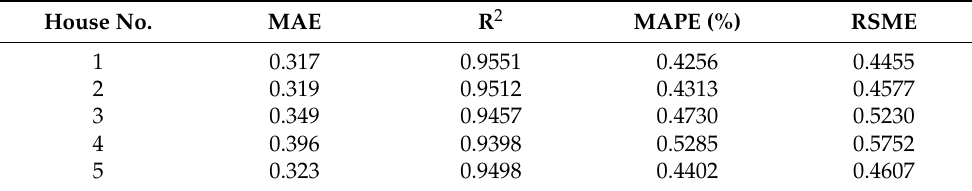
Table 5. Validation matrices for all residences’